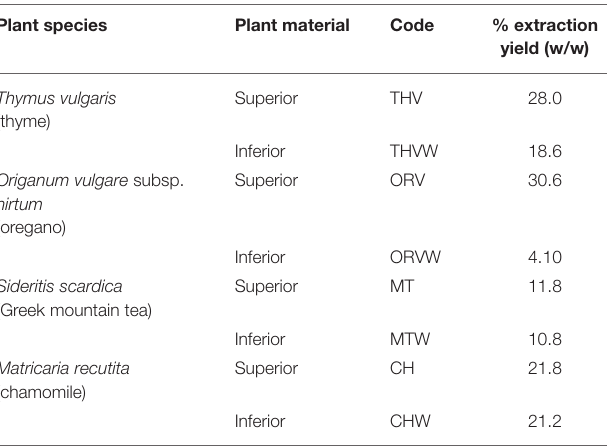
TABLE 2 | Percentage extraction yields of hydroalcoholic extracts deriving from superior and inferior plant material. Plant species Plant